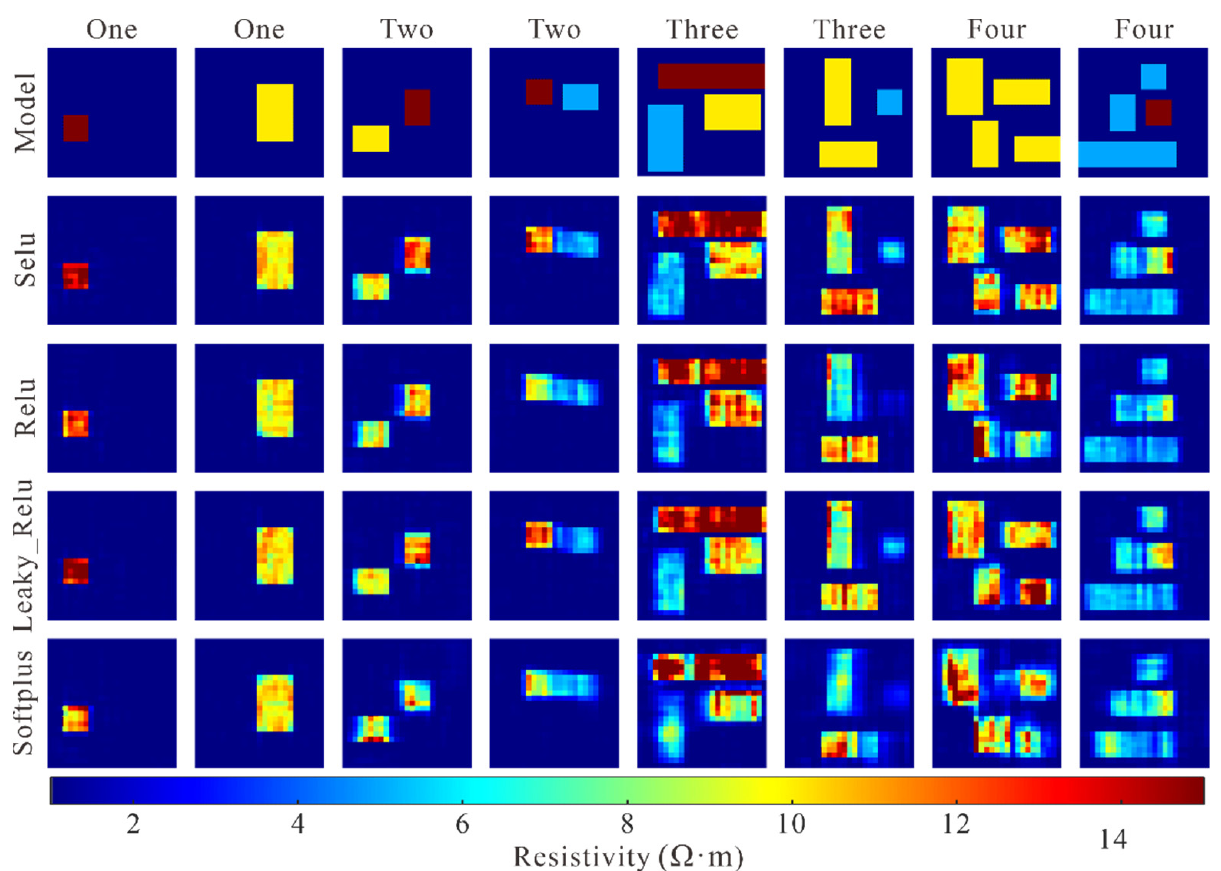
Figure 9. Models and their inversion results in different activation functions. Table 3. The RE and CC of all samples in test set with different activation